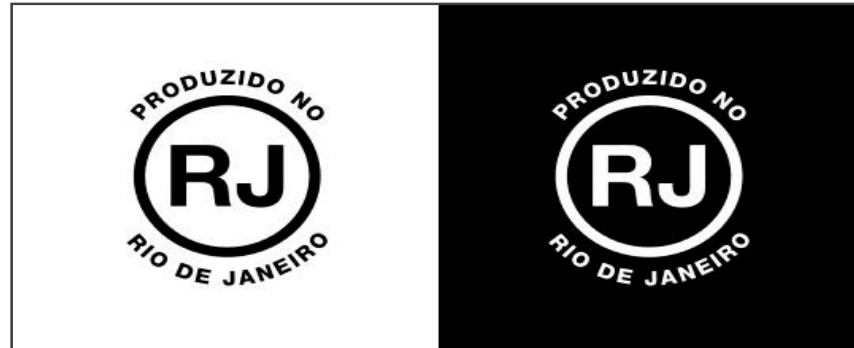
Figure 4. Adaptation of the logo for application on products.